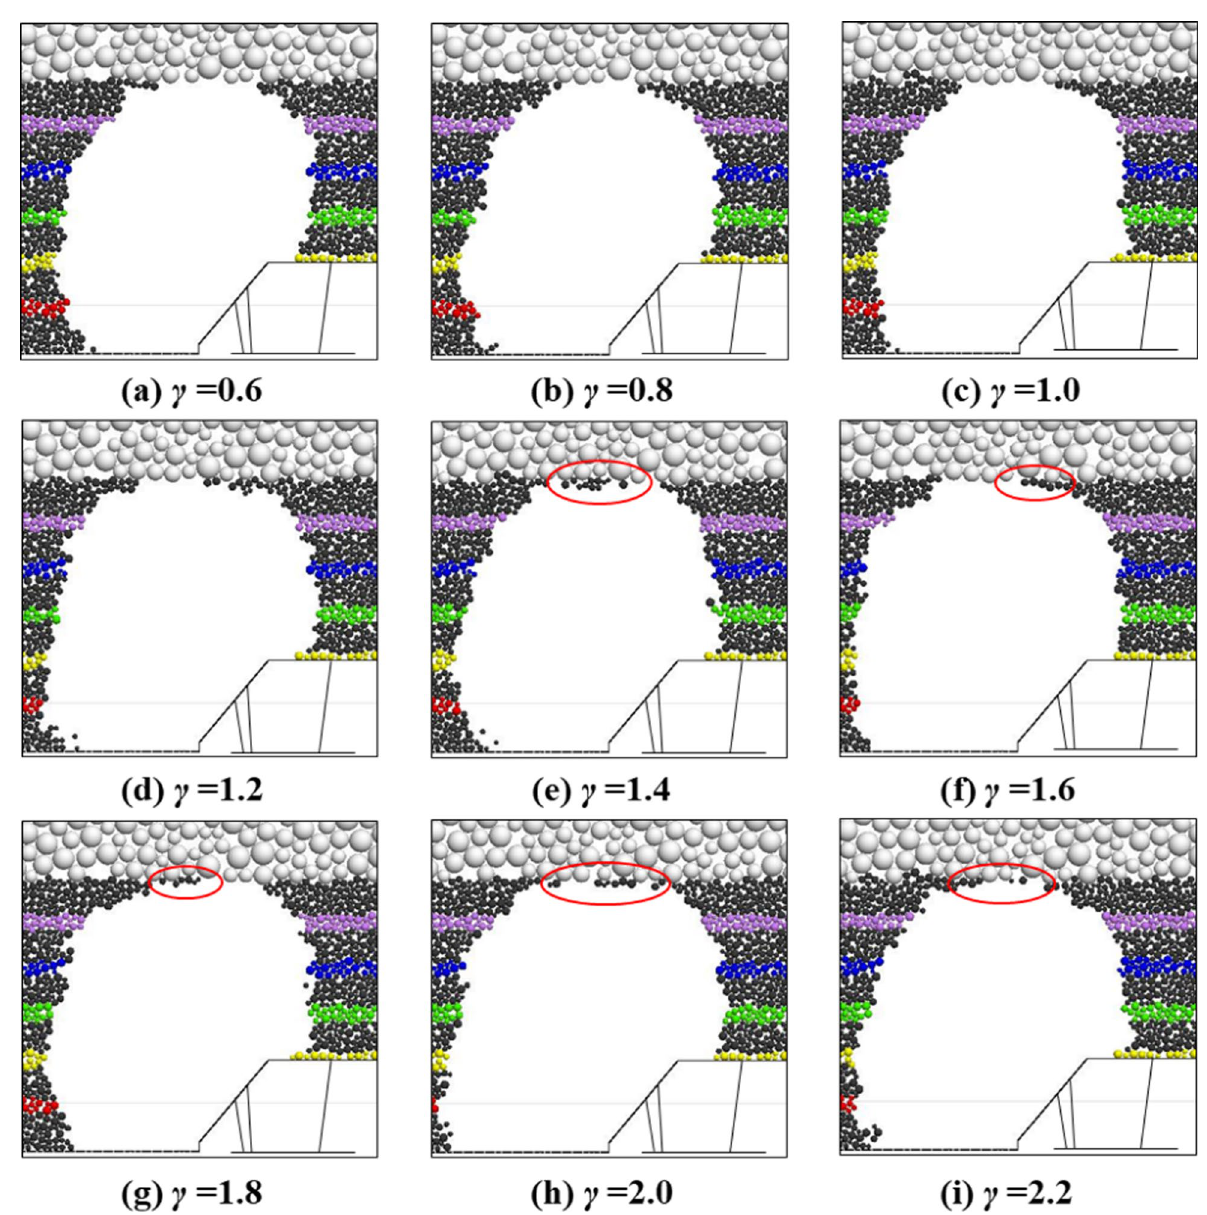
Fig. 6 Shape of the initial drawing body for different density